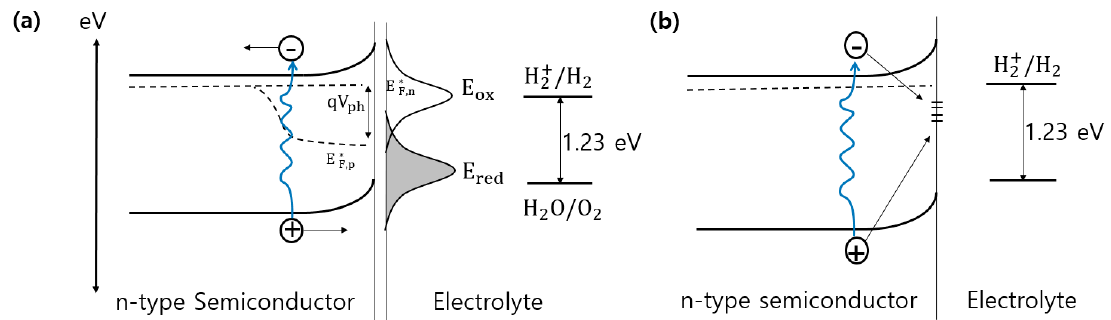
Figure 3. ( a ) A semiconductor photoanode/electrolyte junction under illumination showing the mechanism of photoelectrochemical (PEC) performance. E F,P* and E F,n* denote the quasi-Fermi level of Si for the hole and electron under illumination; E ox and E red indicate the energy levels of a redox couple in the electrolyte. ( b ) Surface recombination of the electron-hole pair induced by the surface states of the semiconductor (i.e., Femi level pinning).